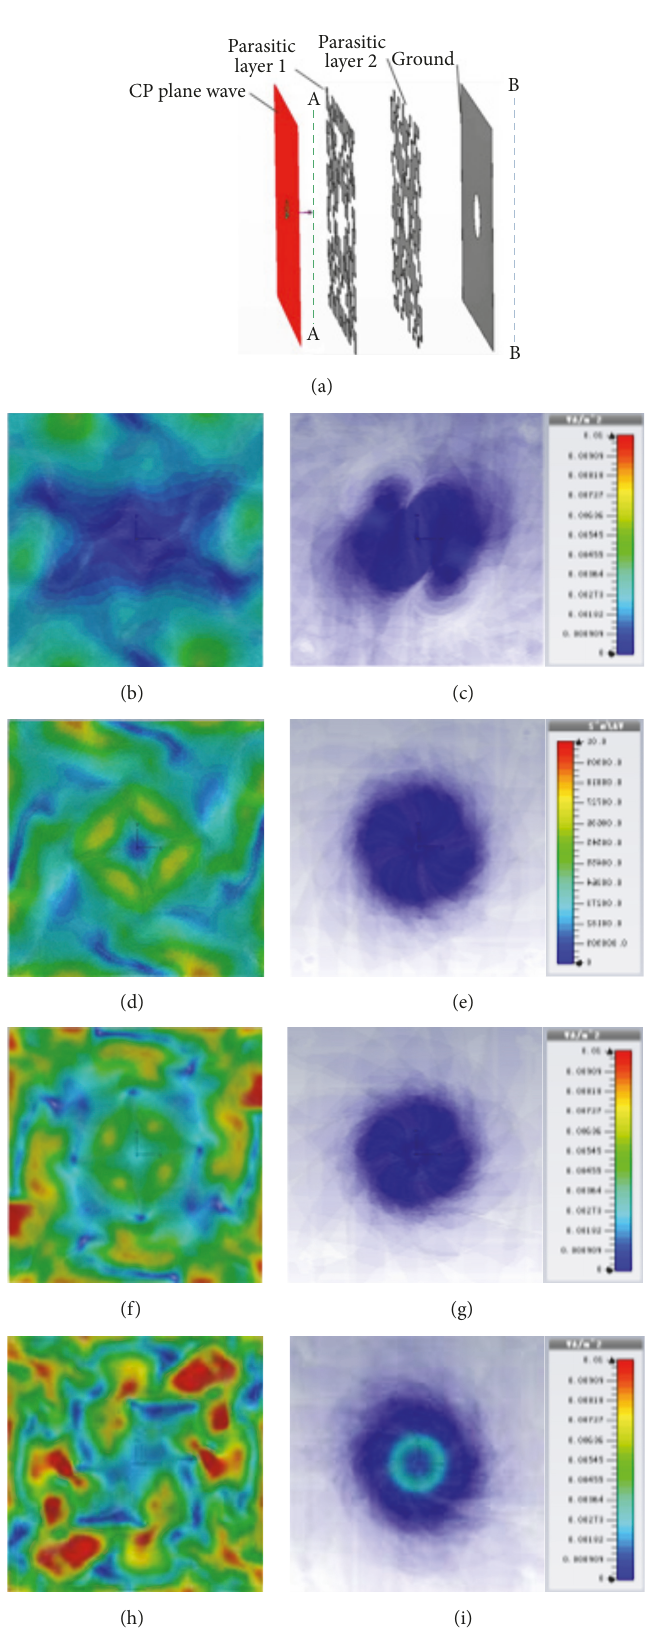
Figure 6: Case 2 : (a) circularly polarized plane wave radiates on the limited ground. Simulated reflected wave power flow density at (b) 4 GHz, (d) 6GHz, (f) 8GHz, and (h) 10 GHz. Simulated transmitted wave power flow density at (c) 4 GHz, (e) 6GHz, (g) 8 GHz, and (i) 10